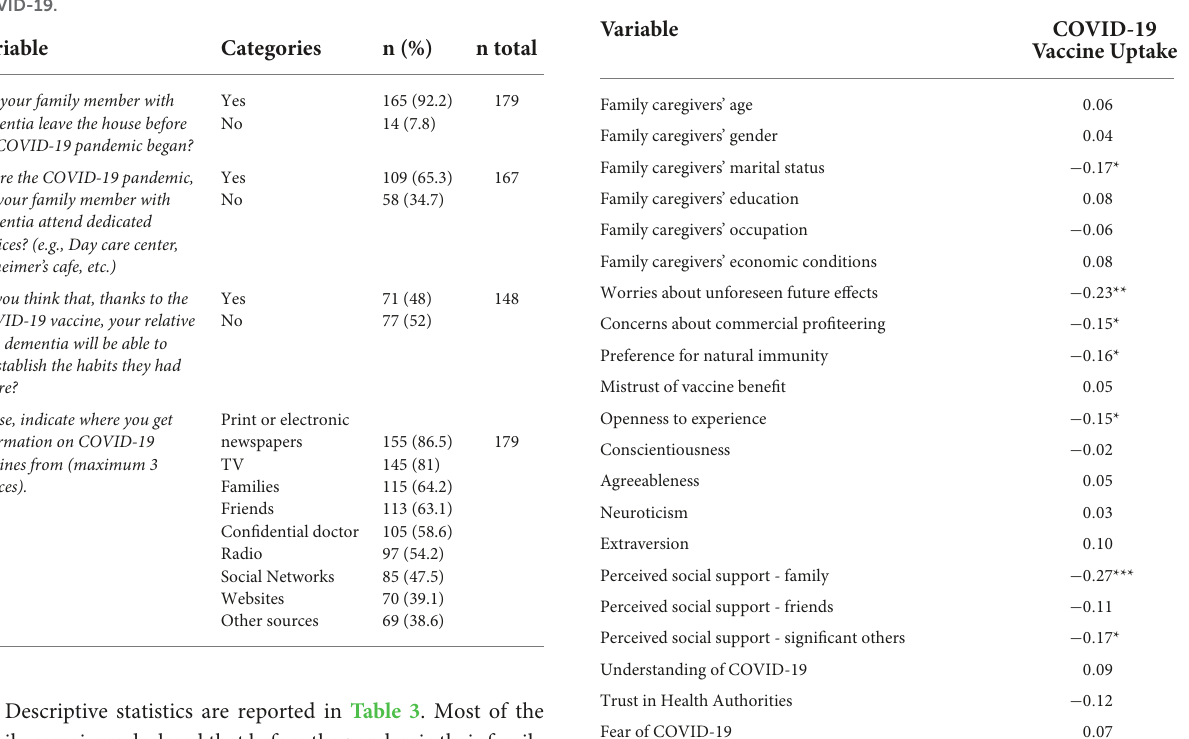
TABLE 4 Correlation matrix with all potential predictor